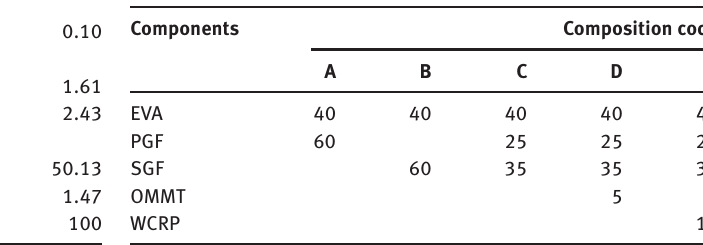
Table 2: Compound formulation (g).